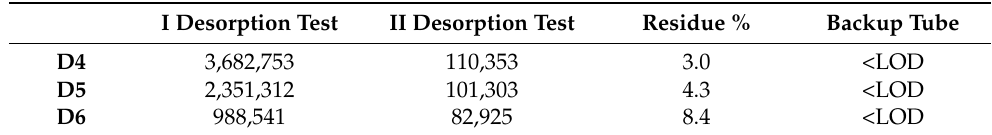
Table 4. Areas of D4, D5, and D6 peaks in the first and second desorption and their memory effect in percentage.